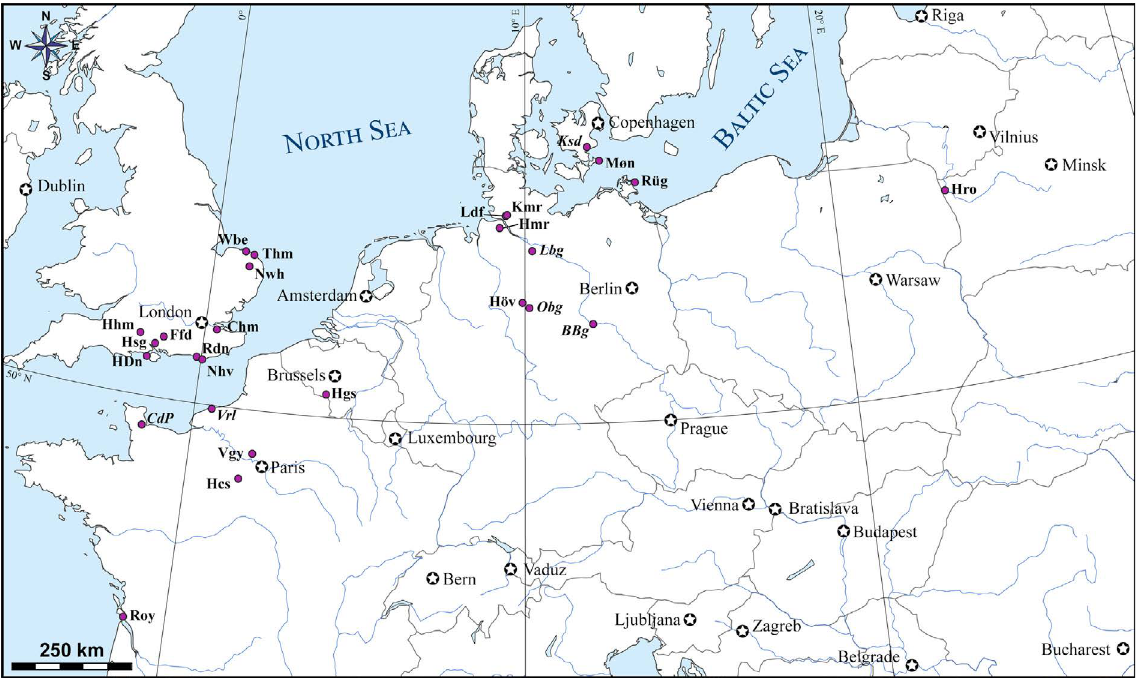
Fig. 1. Map of Europe showing localities of bryozoan material studied (bold) or mentioned (italics) in this study. Abbreviations: BBg = Blaue Berge near Dessau-Roßlau, Saxony-Anhalt, Germany; CdP = Chef-du-Pont, Normandy, France; Chm = Chatham, Kent, England, UK; Ffd = Froxfield south of Alton, Hampshire, England, UK; Hcs = Hanches, Centre-Val de Loire, France; HDn = High Down, Isle of Wight, England, UK; Hgs = Harmignies near Mons, Wallonia, Belgium; Hhm = Harnham SW of Salisbury, Wiltshire, England, UK; Hmr = Hemmoor, Lower Saxony, Germany; Höv = Alemannia quarry, Sehnde-Höver, Lower Saxony, Germany; Hro = quarry near Hrodna/Grodno (Гродна/Гродно), Grodno Region, Belarus; Hsg = Hensting Farm, Owslebury, near Winchester, Hampshire, England, UK; Kmr = Saturn quarry near Kronsmoor, Schleswig-Holstein, Germany; Ksd = Kongsted Sogn in the Faxe Kommune, Sjælland, Denmark; Lbg = Lüneburg, Lower Saxony, Germany; Ldf = Lägerdorf, Schleswig-Holstein, Germany; Møn, Island of Møn, Denmark; Nhv = Newhaven, East Sussex, England, UK; Nwh = Norwich, Norfolk, England, UK; Obg = Lahstedt-Oberg, Lower Saxony, Germany; Rdn = between Brighton and Roedean, East Sussex, England, UK; Roy = Royan, Nouvelle-Aquitaine, France; Rüg = Rügen, Mecklenburg-Vorpommern, Germany; Thm = Trimingham, Norfolk, England, UK; Vgy = Vigny, Île-de-France, France; Vrl = Vasterival, Sainte-Marguerite-sur-Mer, Normandy, France; Wbe = Weybourne, Norfolk, Norfolk, England,